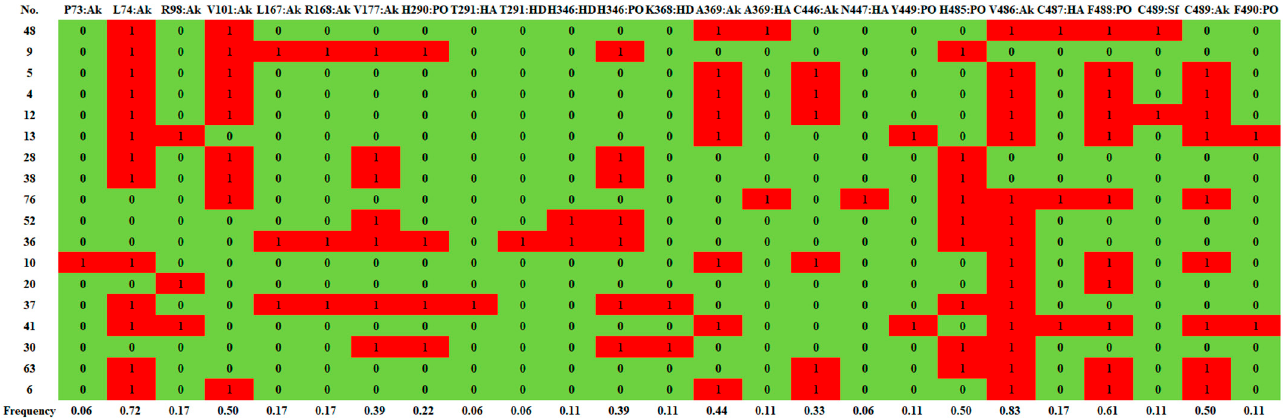
Figure 3. ( A ) LUMO orbit of d-limonene. ( B ) d-limonene group compounds docking with ES. ( C ) Active residues around d-limonene docking with ES.